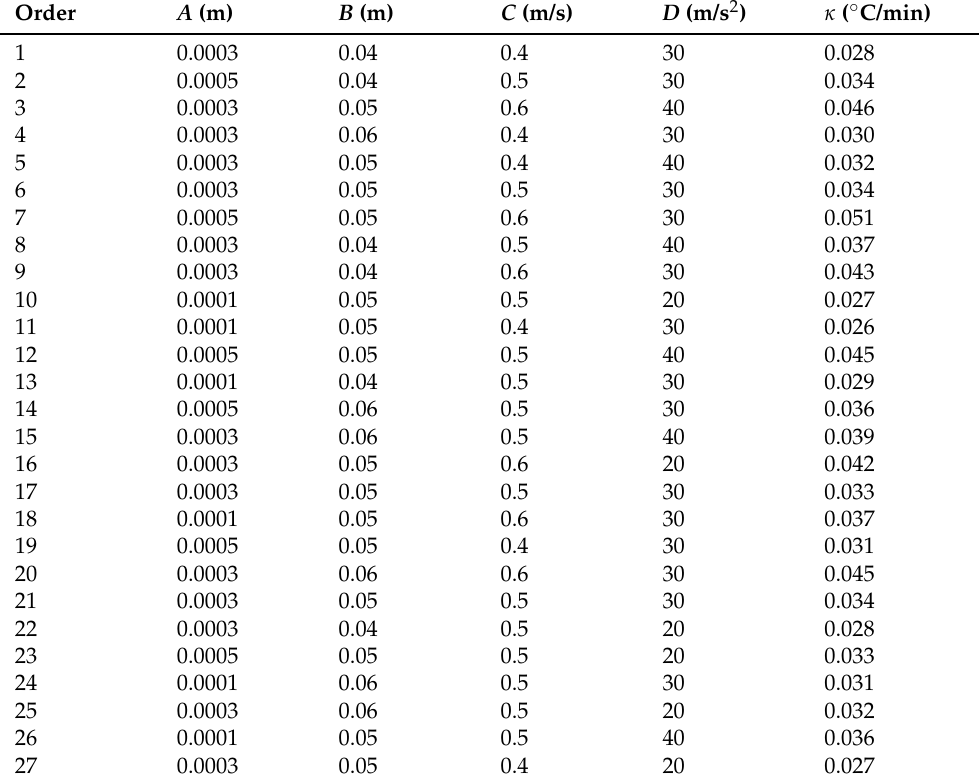
Table 4. Variables and levels in Box–Behnken and response values for TCR.